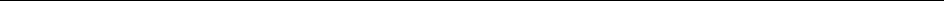
( n = 100/experiment). i Schematic of the interaction between RTTN and STIL. Scale bar , 5 μ m in f ; Scale bar , 0.5 μ m in g and